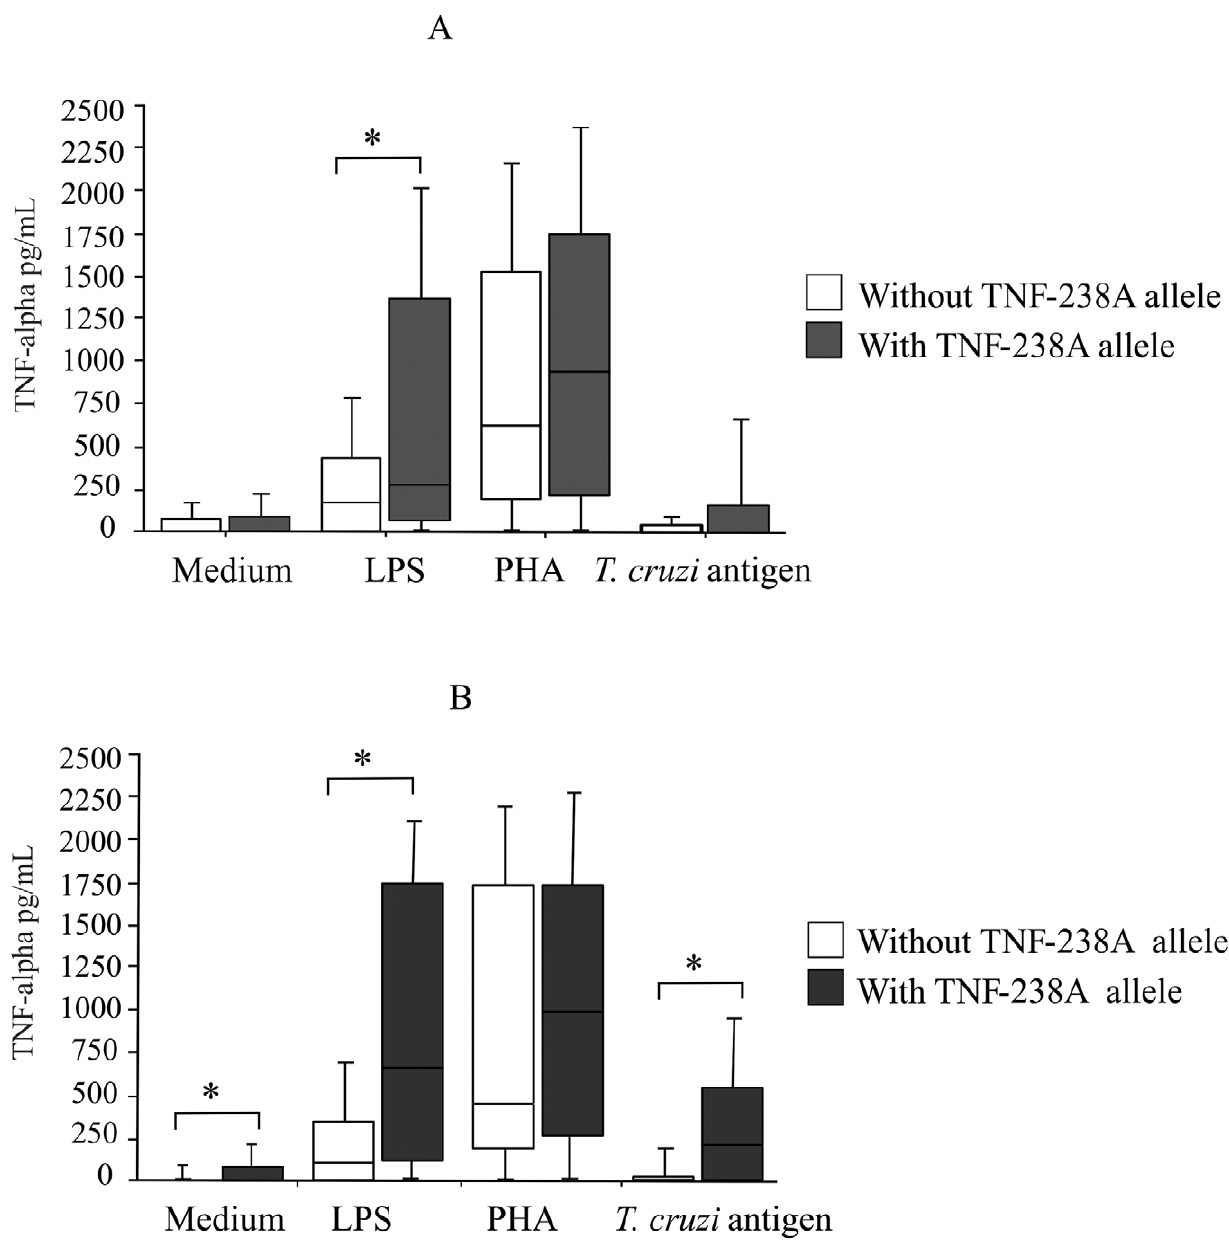
Figure 3. Levels of TNF-alpha in culture supernatants. TNF-alpha was assayed by ELISA in supernatants of PBMC cultured for 48 h in the absence of any stimulus and in the presence of T. cruzi antigen, LPS and PHA. A. Subjects with positive serology and negative serology were grouped according to the presence or absence of the TNF-238A allele; *p=0.045 (Mann-Whitney test). B. Only subjects with positive serology were grouped according to the presence or absence of the TNF-238A allele; * p=0.04 compared to medium, p=0.004 compared to T. cruzi antigen, and p=0.007 compared to LPS (Mann-Whitney test). Results are expressed as pg/mL. The horizontal line indicates the median, bars the 25% and 75% percentiles, and vertical lines the 10% and 90%